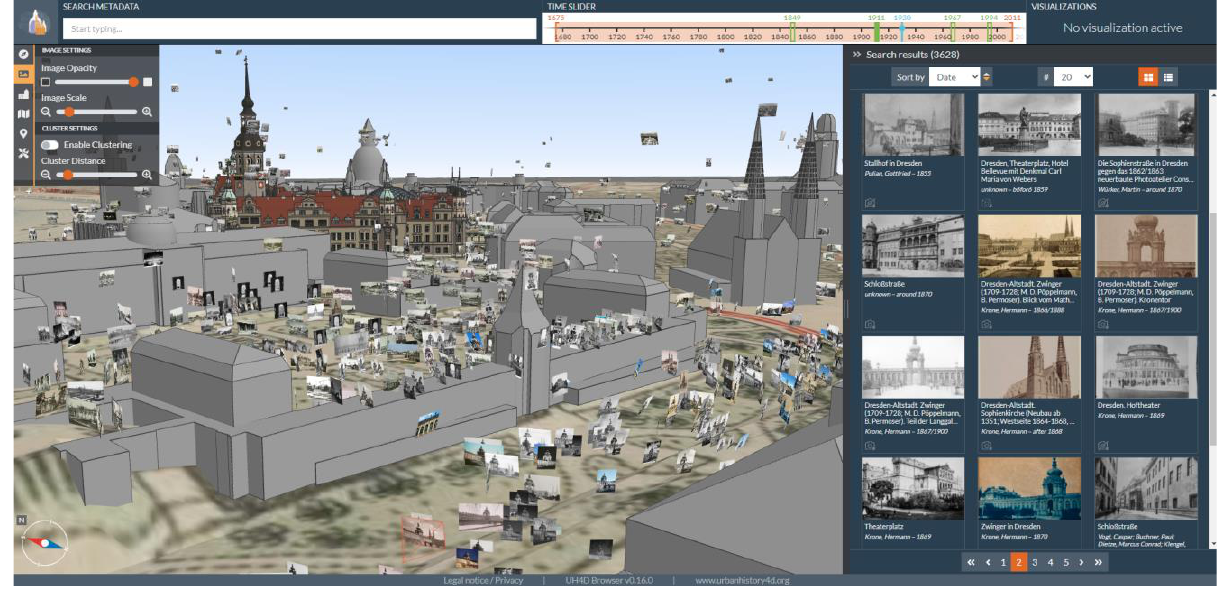
Figure 3. 4D browser interface with spatially oriented photographs within a 3D city model and time